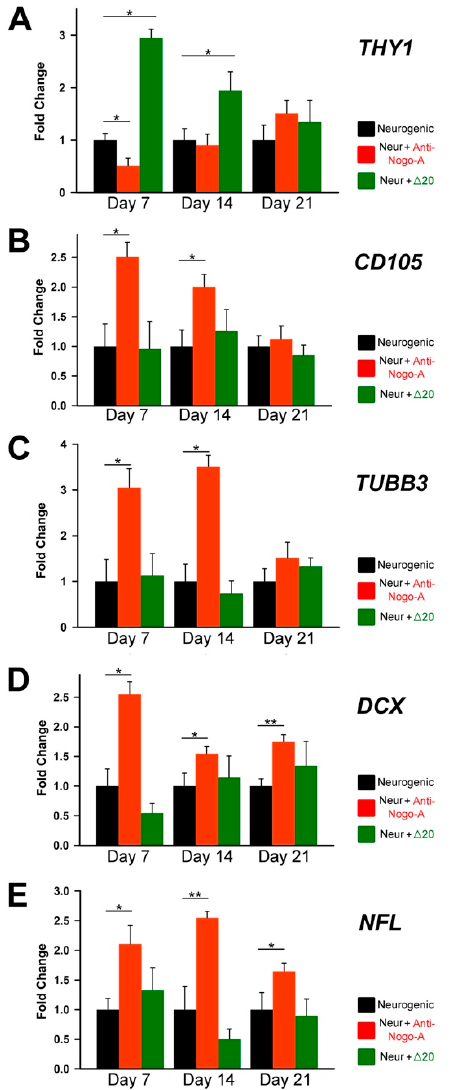
Figure 9. Effects the Nogo-A protein and anti-Nogo-A antibody on the expression of genes during hDPSC neuronal differentiation. qRT-PCR analysis of the relative expression levels of THY1/CD90 ( A ), END/CD105 ( B ), TUBB3 ( Tubulin Beta-III ; ( C )), DCX ( Doublecortin ; ( D )) and NFL ( Neurofilament-L ; ( E )) in hDPSCs cultured in neurogenic medium (Neur) alone (black columns), in neurogenic medium supplemented with the anti-Nogo-A antibody (red color columns), and in neurogenic medium supplemented with the Nogo-A ∆ 20 protein (green color columns) for 7, 14 and 21 days. Values, normalized to Glyceraldaeyde-3-Phosphate Dehydrogenase (GAPDH), shown are the mean ± SD of triplicates. Statistical analysis used Student’s t-test (significant difference at *, p < 0.05; **, p <